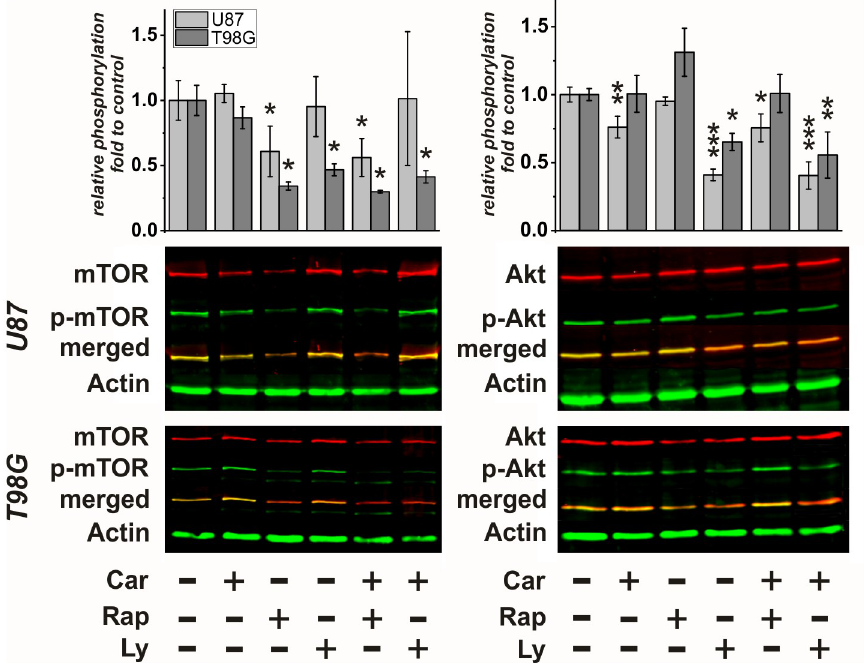
Fig 4. Phosphorylation of mTOR and Akt under the influence of carnosine, rapamycin and Ly-294,002. Cells from the lines U87 and T98G were incubated in the presence of carnosine (Car; 50 mM), rapamycin (Rap; 25 nM), Ly- 294,002 (Ly; 5 μ M) or vehicle control or a combination of the compounds. Proteins were isolated, subjected to SDS-PAGE and Western Blotting was performed using antibodies for mTOR and mTOR phosphorylation at serine 2448 (mTOR and p-mTOR; left) and antibodies against Akt and Akt phosphorylation at serine 473 (Akt and p-Akt right). In the lower part, representative blots are presented in which the total amount of each signaling molecule is detected by red fluorescence and its corresponding phosphorylated form by green fluorescence. Below the combined bands are shown (merged) in yellow. Actin served as loading control (green fluorescence). A densitometry analysis from six (U87) and three (T98G) independent experiments was performed with each set of the two primary antibodies. Data is presented as “relative phosphorylation”, indicating the ratio of the signal obtained with the phospho-specific antibody compared to the signal with the antibody direct against total protein of the factor under the influence of a compound, compared to this ratio in untreated control cells (set as 1). Statistical significance was calculated by one- way ANOVA with the Games-Howell post hoc test: � : p < 0.05; �� : p < 0.005, and ��� : p <